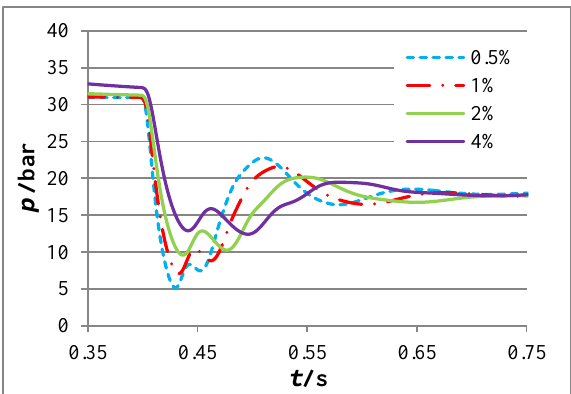
Fig. 10. Influence of undissolved air content (in %) on pressure response .